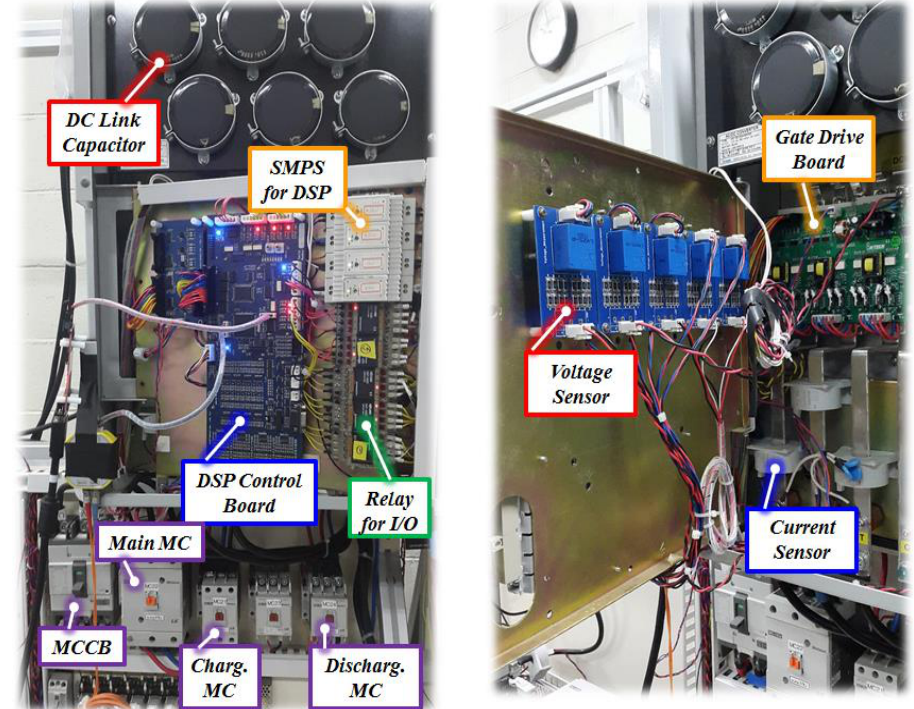
Figure 24. Experiment setup 2 of the 3-phase AC/DC PWM converter. SMPS: switched-mode power